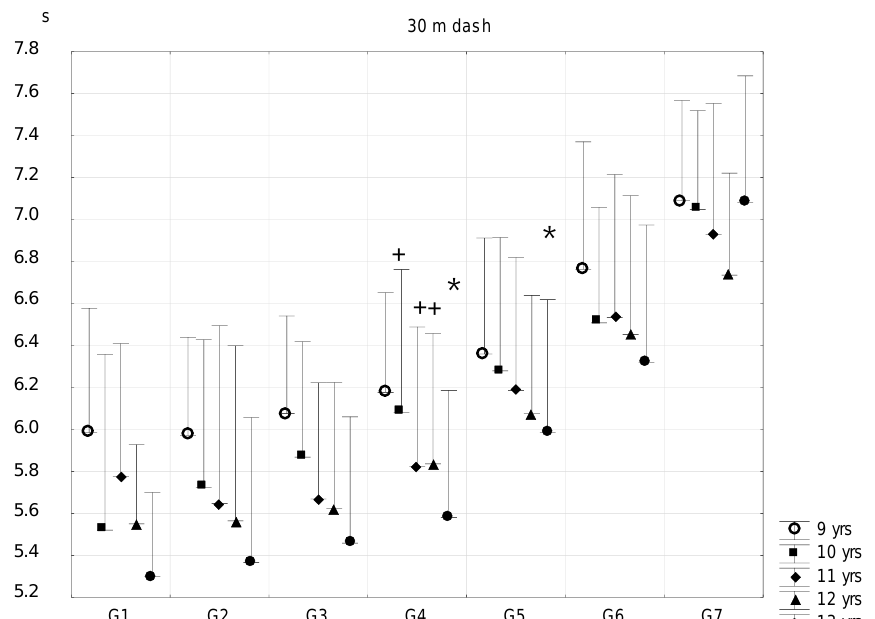
Figure 8. Relationship between body fat percentage and 30 m dash (mean + SD). 1—F% < 8.00; 2—F% = 8–11.99; 3—F% = 12.00–15.99; 4—F% = 16.00–19.99; 5—F% = 20.00–23.99; 6—F% = 24.00–27.99; 7—F% > 28; F% body fat percentage; * significant difference among subsequent groups; + significant difference in certain consecutive groups, p < 0.05.